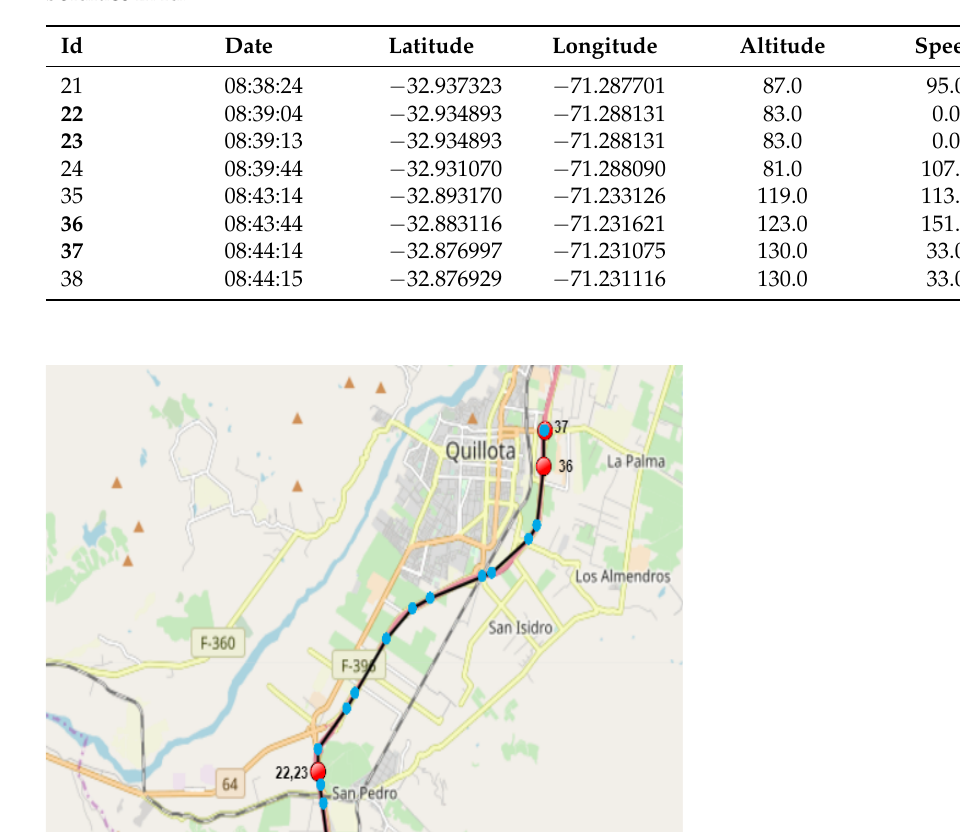
Table 10. Detail of GPS measurements with the greatest error, including contiguous ones, of the trajectory of Figure 7. The measurements that most contribute to the trajectory error are indicated in boldface in Id.